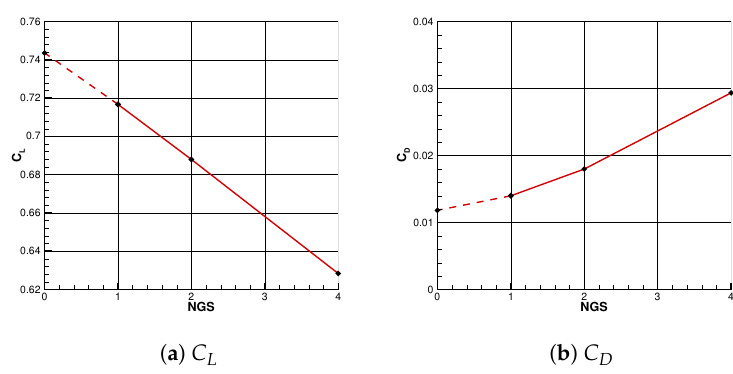
Figure 14. Grid convergence analysis for UZEN solver.